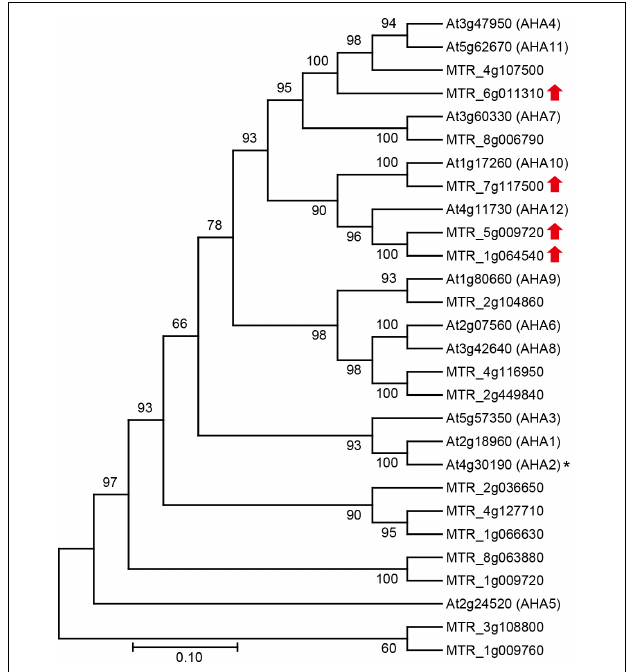
FIGURE 4 | Phylogenetic analysis of PM H + -ATPase gene family members in M. truncatula and Arabidopsis thaliana . The upward red arrows indicates that the genes are up-regulated in the alkali stress-induced detached leaf senescence in M. truncatula ; and the asterisk shows the alkaline-stress-regulated PM H + -ATPase gene in Arabidopsis. The scale bar indicates the sequence divergence is 0.10 per unit bar.